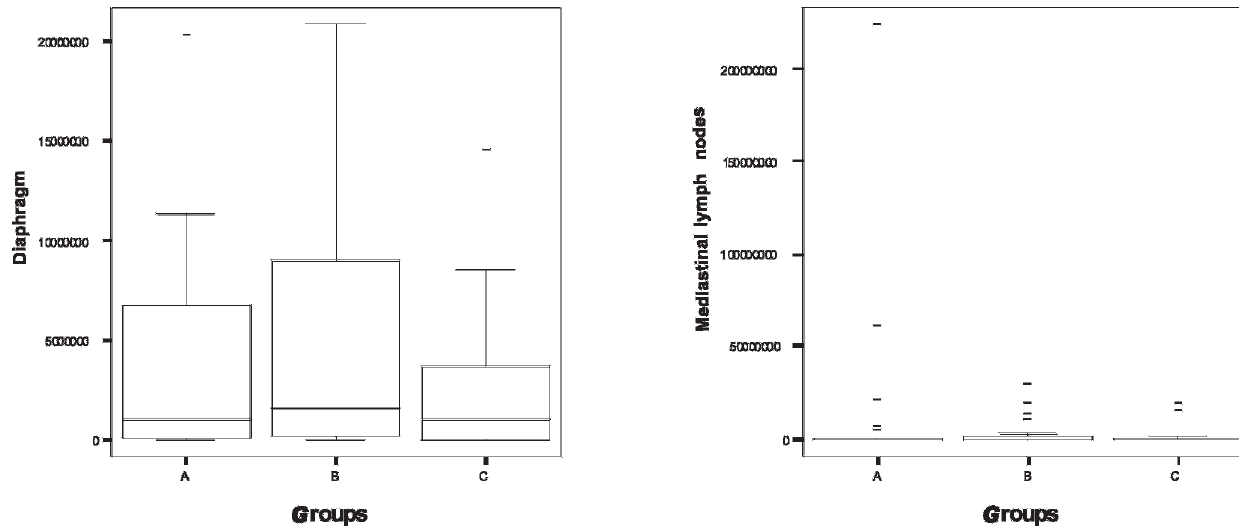
Figure 1 - Box-plots for diaphragmatic and mediastinal lymph node tissue cultures. Groups: A=no pneumoperitoneum, B=pneumoperitoneum, and C=pneumoperitoneum + mechanical